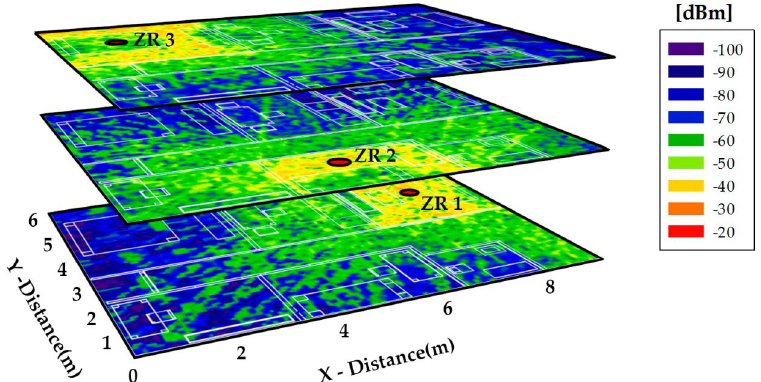
Figure 11. Power distribution in the scenario when transmitters are placed in the ceiling of living room (ZR1), guess bedroom (ZR2) and main bedroom (ZR3).